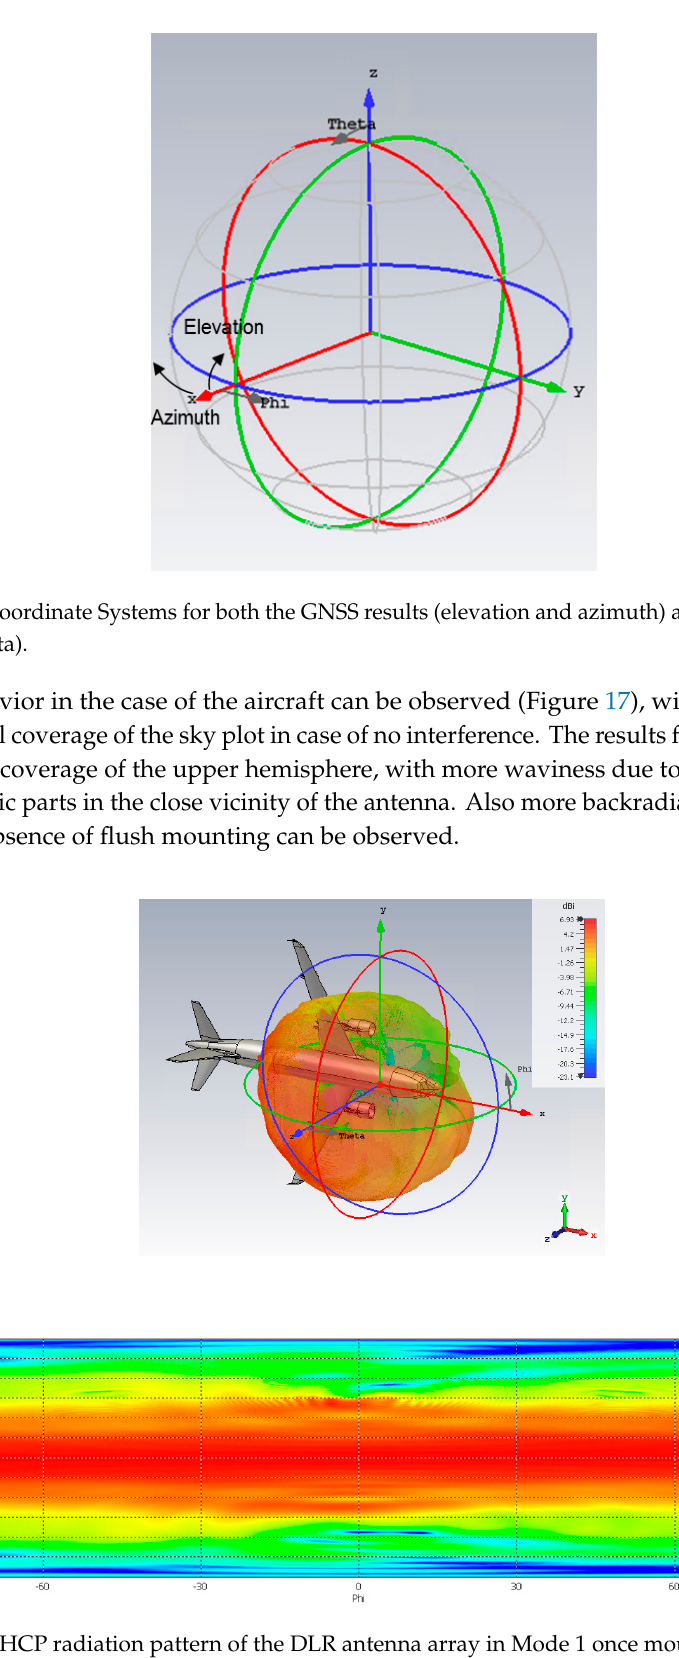
Figure 17. RHCP radiation pattern of the DLR antenna array in Mode 1 once mounted on an aircraft: ( top ) 3D view; ( bottom ) 2D view.